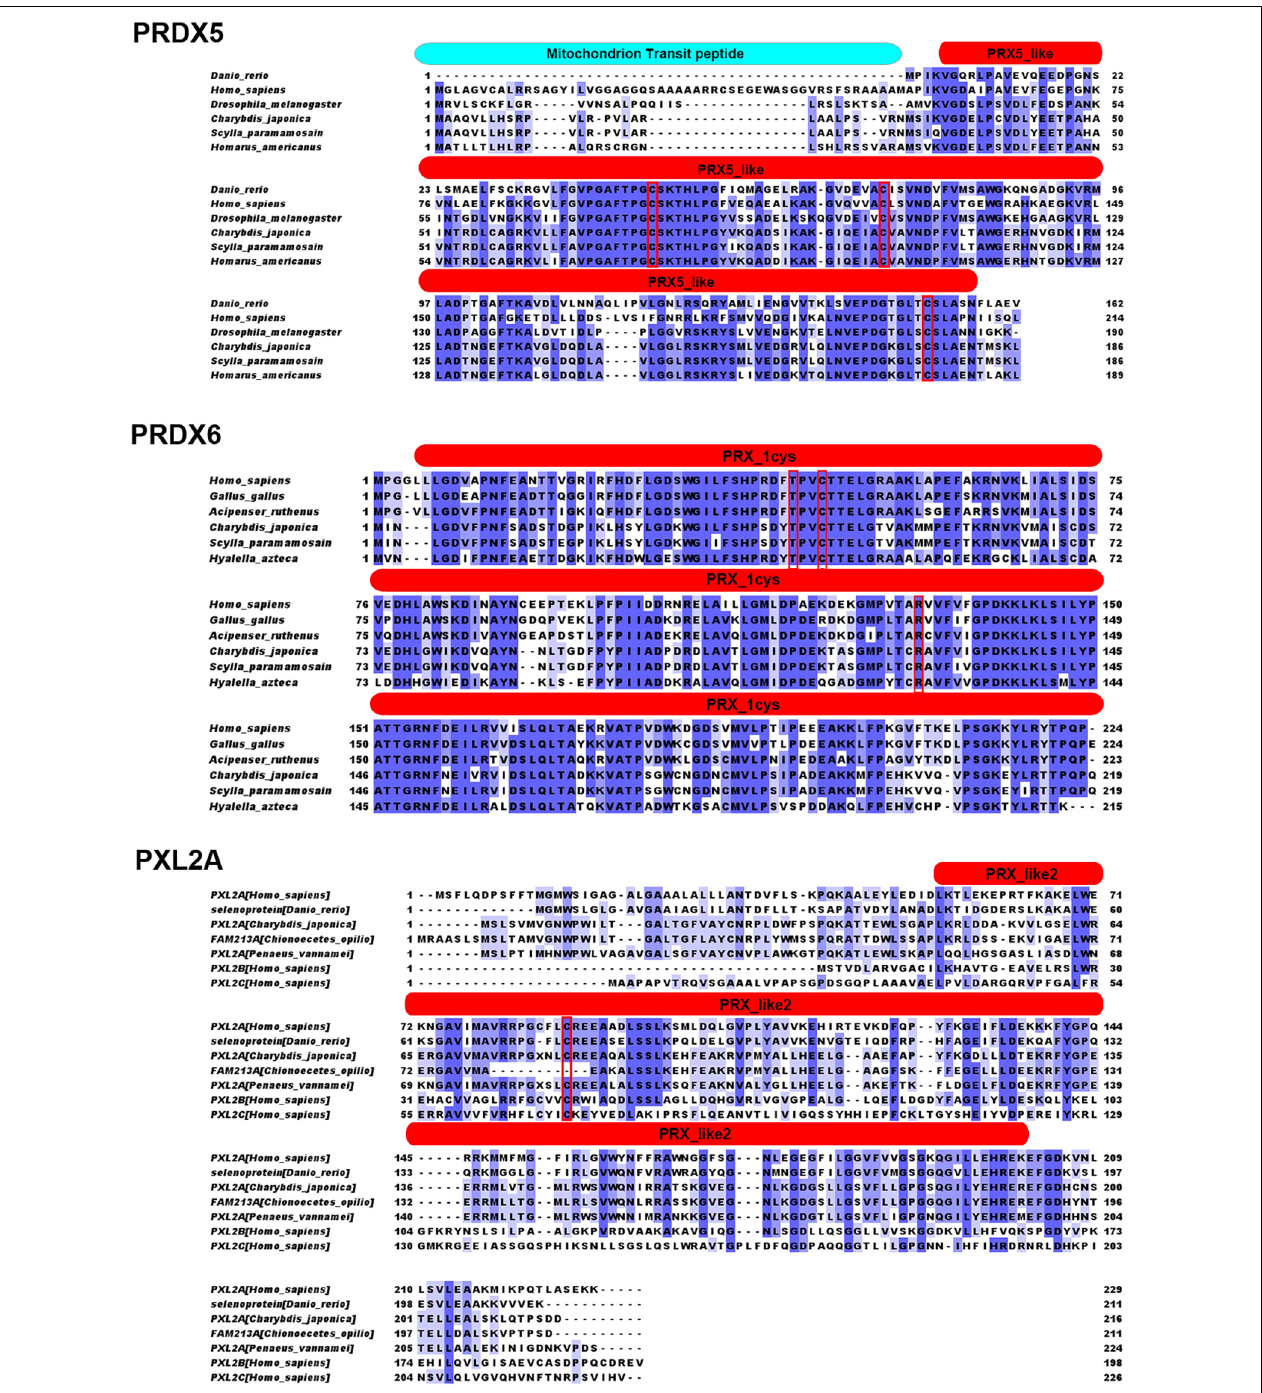
FIGURE 2 | Results of the similarity analysis of PRDX5, PRDX6, and PXL2A. The red box is The important active site (R, T, and C), cysteine sulfenic acid (-SOH) intermediate, for peroxidase activity. The red entity box is located in the conservative domains of redoxin, PRX_1cys, and